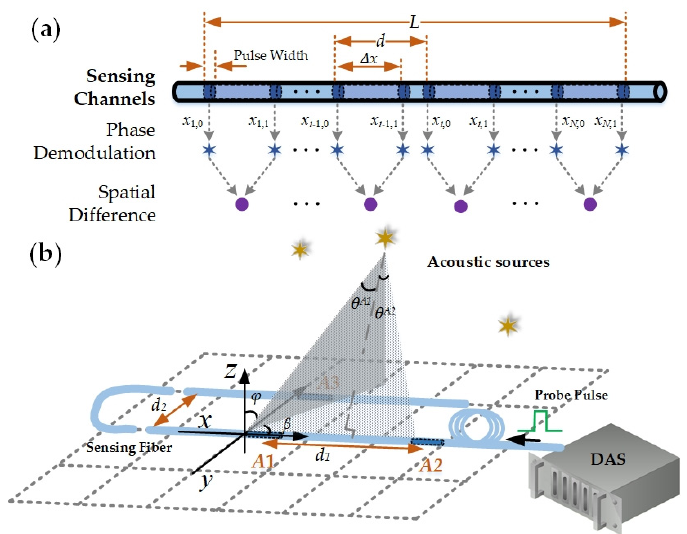
Figure 16. ( a ) Array model of DAS; ( b ) Array layout for 2D/3D localization in experiments. Reproduced with permission from our previous paper [29], published by Optical Society of America, 2019.